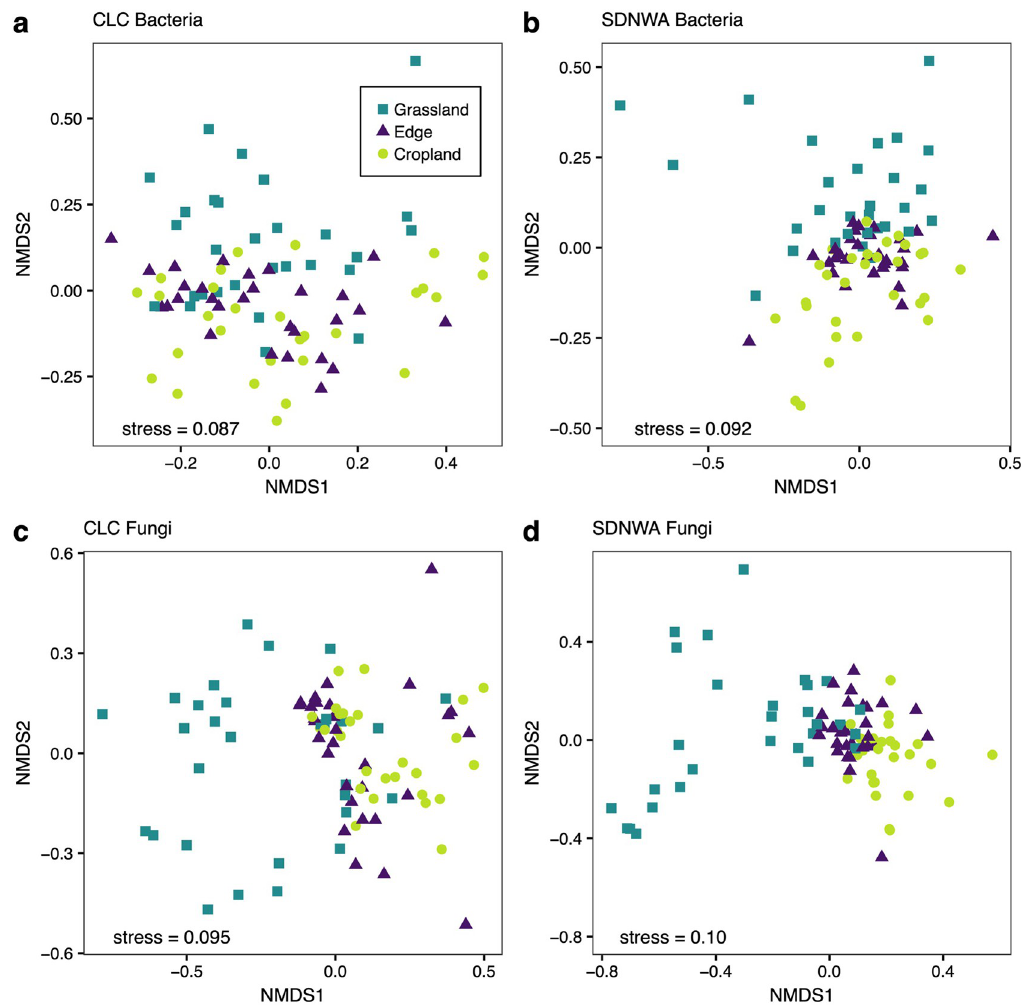
Fig 3. Non-metric multidimensional scaling analysis of microbial community across croplands and perennial grasslands. Non-metric multidimensional scaling analysis for the (a, b) bacterial community and the (c, d) fungal community at the Conservation Learning Centre (CLC) and St. Denis National Wildlife Area (SDNWA). Shape and colour of the points represent location across the edge; perennial grassland (teal squares), edge (purple triangles), and cropland (yellow circles).